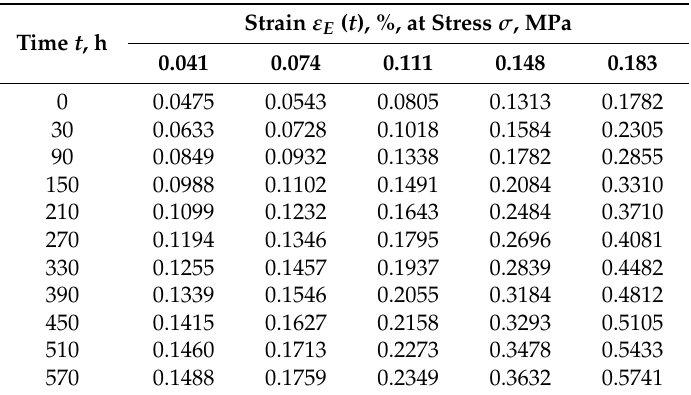
Table 4. Values of creep strain for asphalt